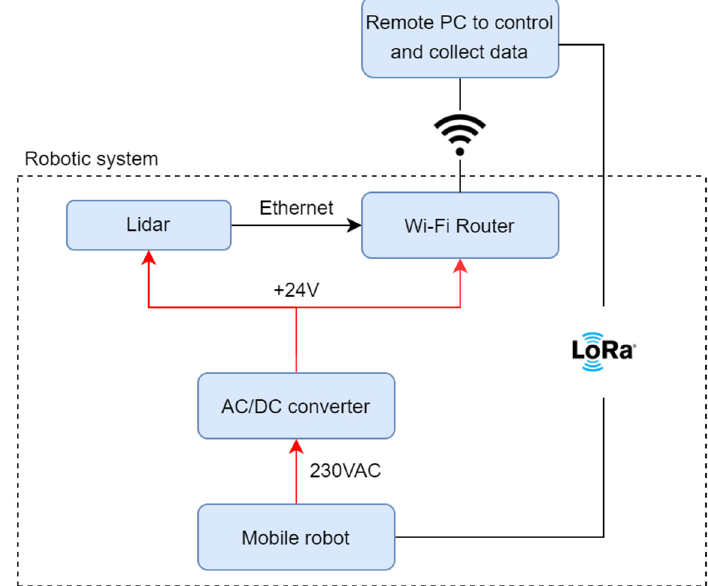
Figure 2. A robotic system with omnidirectional chassis.